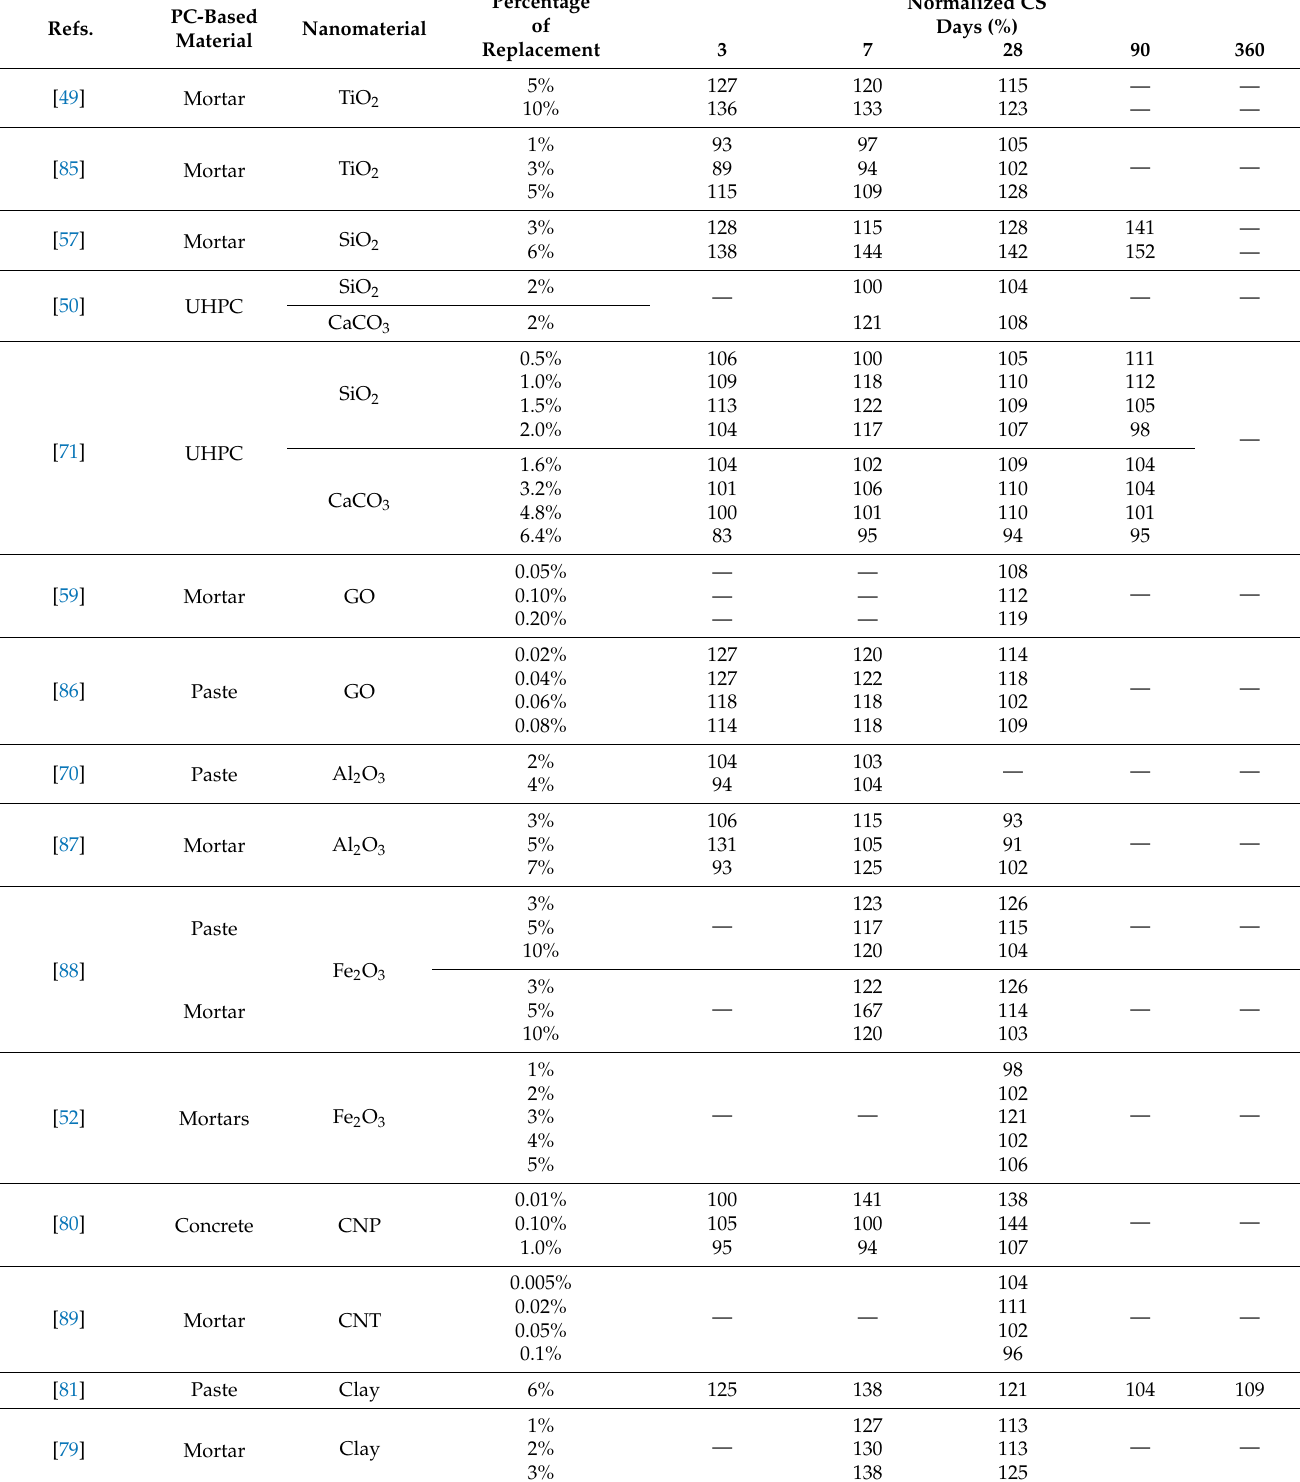
type, and chemical additives. Table 2 lists normalized CS values to compare the effect of the partial substitution of PC by nanomaterials in different PC-based materials and ages. Table 2. Normalized CS of PC-based materials manufactured with nanomaterials.